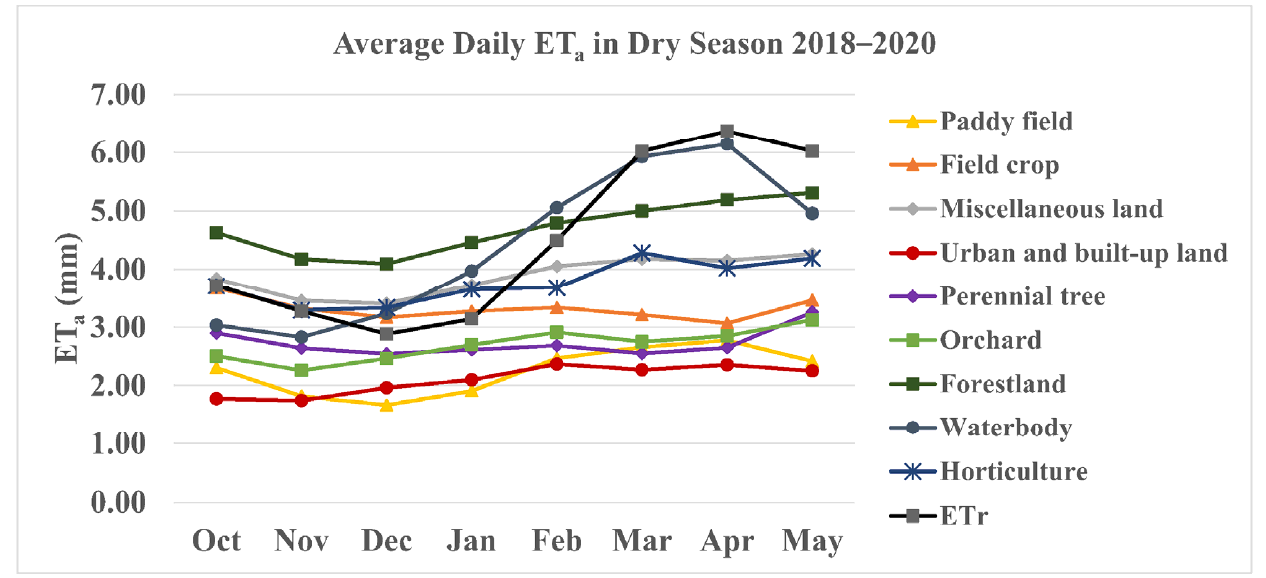
Figure 6. Average daily actual evapotranspiration ( ET a ) and standardised alfalfa reference ET equation ( ET r ) for nine land-use types in the study area in the Chiang Mai and Lamphun provinces, which are located on the plains of the upper northern region of Thailand along the Ping River, during the dry seasons of 2018–2020.